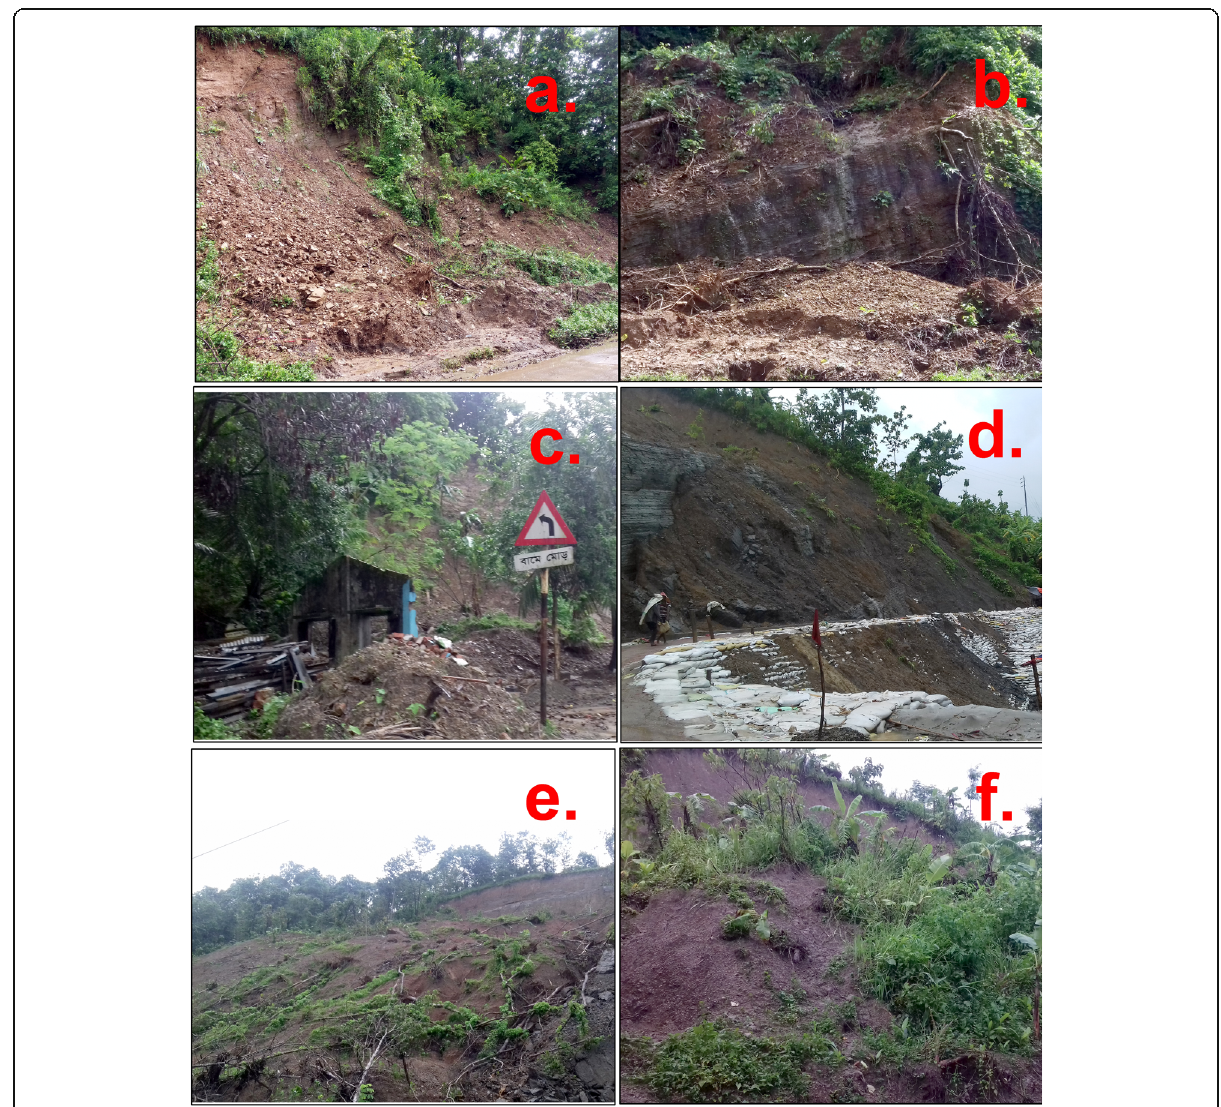
Fig. 2 Images of Some of the Landslides and Associated Damages Occurred on the June 13, 2017: a . and b . Landslides in the Chittagong- Rangamati Highway; c . A Collapsed School Building in Rangamati Sadar; d . Damaged Road and Nearby Bridge; e . and f. Damaged Plantation Agriculture